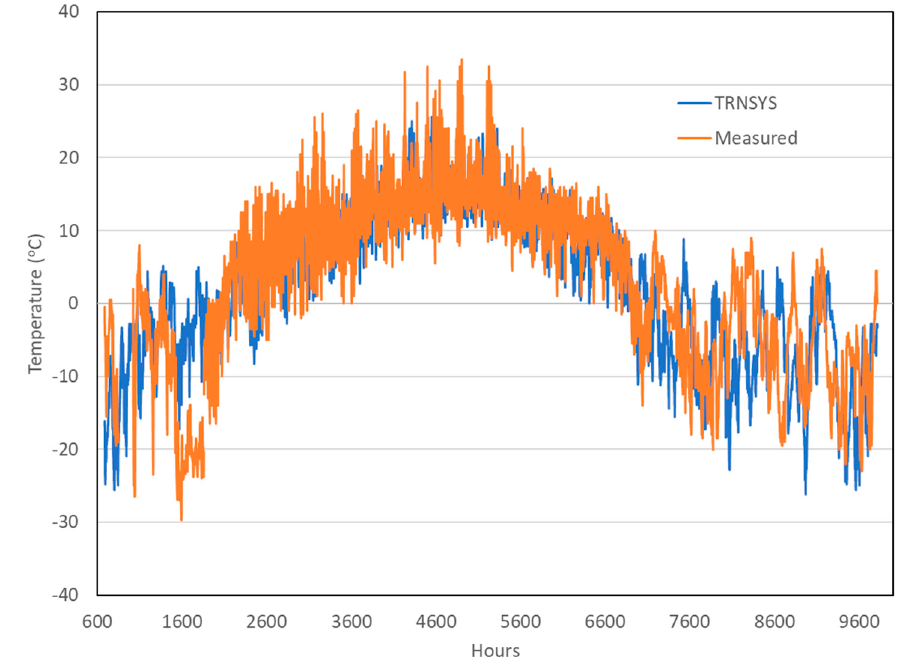
Figure 10. Comparison mf measured ambient temperature and TMY2 data.